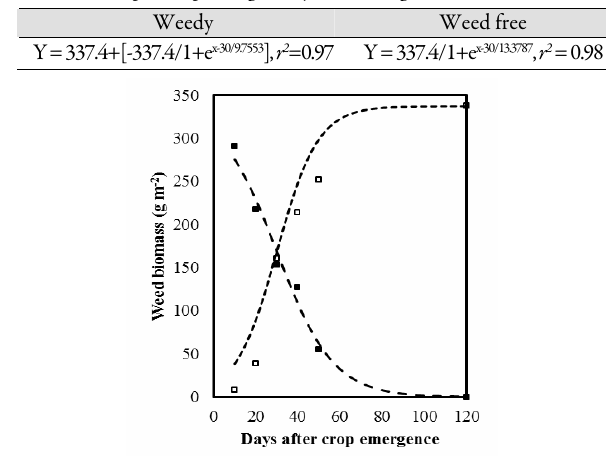
Table 1. Boltzmann equations for weed dry weight accumulation in weedy and weed-free plots depending on days after emergence (X)